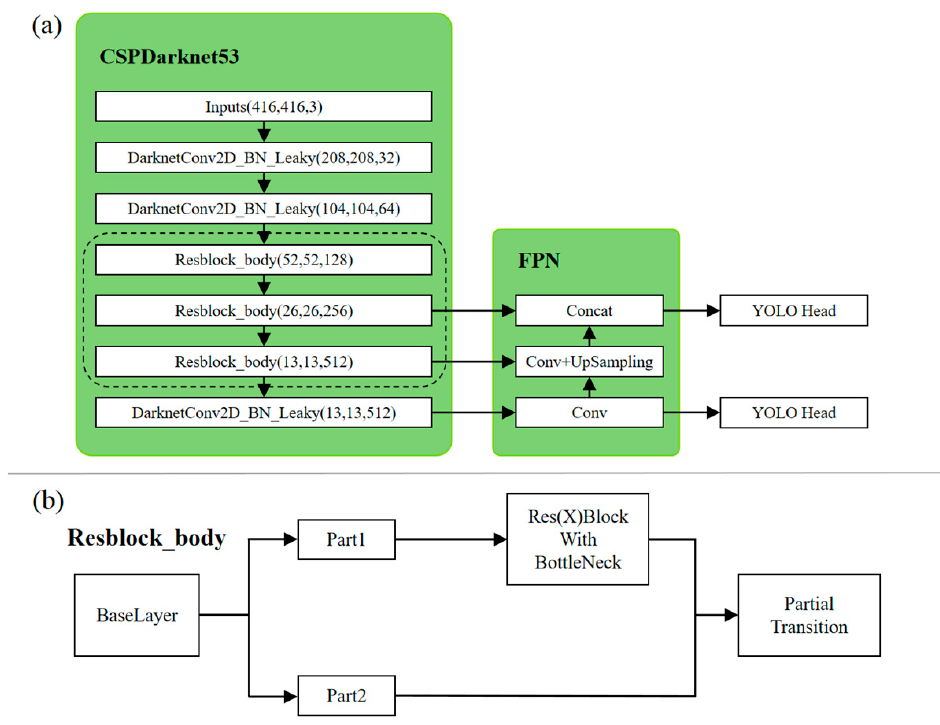
Figure 2. ( a ) YOLOv4-tiny network structure. ( b ) Resblock_body module structure.